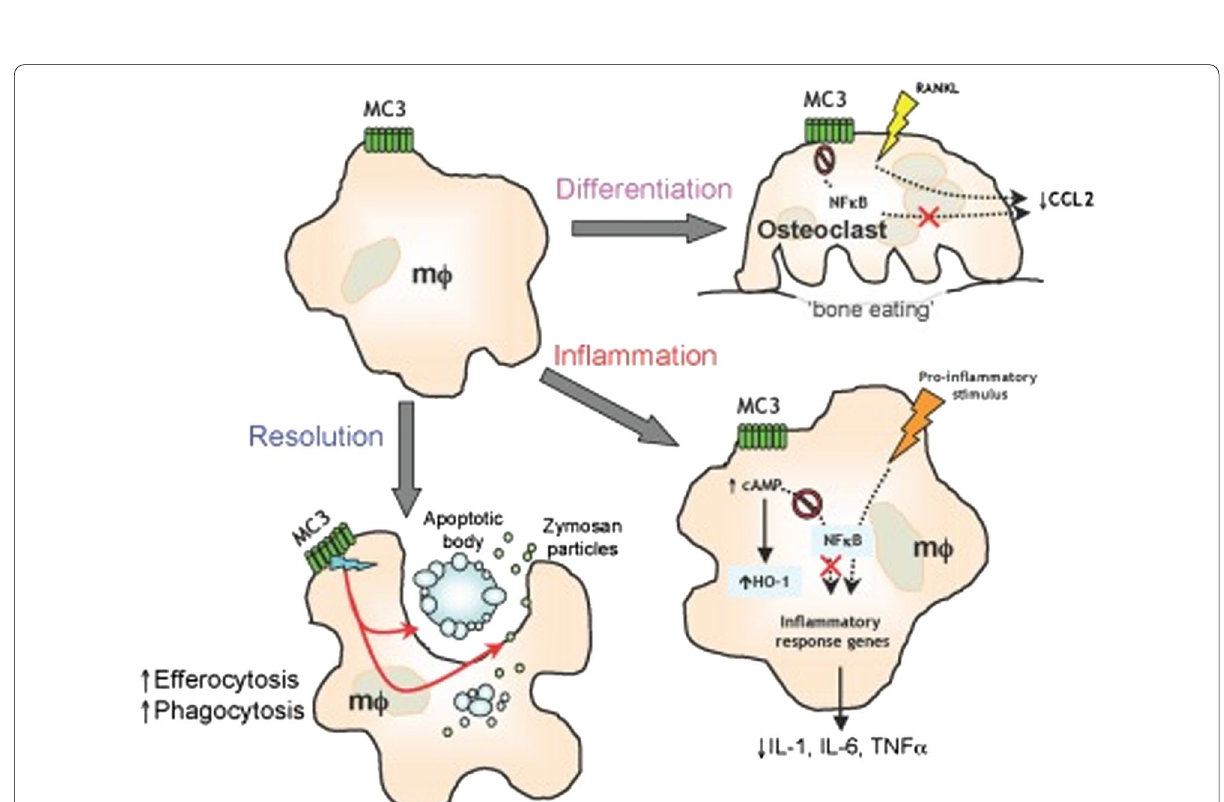
Fig. 4 Type 3 melanocortin receptor activation on macrophage function MC3 activation by endogenous or selective synthetic agonists leads to regulation of osteoclast generation, control of pro-inflammatory and anti-inflammatory mediators, and resolution of inflammation by spherocytosis and